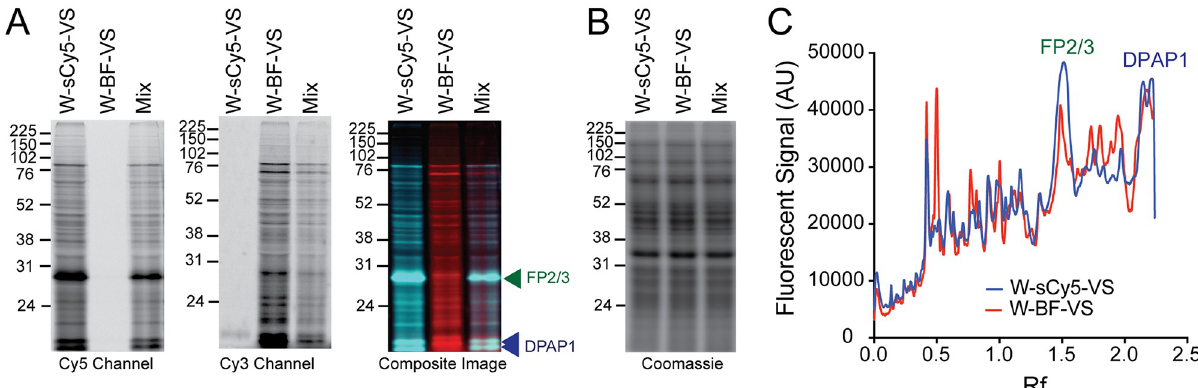
Fig 4. Comparison of labelling profiles of W-sCy5-VS and W-BF-VS. ( A ) Schizont lysates were treated for 1 h either with 0.5 μ M of W-sCy5-VS, W-BF-VS, or a mixture of both probes, each at 0.5 μ M (Mix). After running the samples in a SDS-PAGE gel, the gel was scanned either in the Cy5 and Cy3 channels. The composite image shows very similar labelling profiles for both probes and a clear co-migration of the labelled bands in the Mix sample. ( B ) Coomassie staining of the gel shown in A showing equal protein loading. ( C ) Quantification of the labelling profiles for each probe by densitometry. Fluorescent intensity vs. migration distance (Rf) is shown. The position of FP2/3 and DPAP1 are indicated in A and C. Two additional biological replicates of this experiment are shown in S5 Fig.